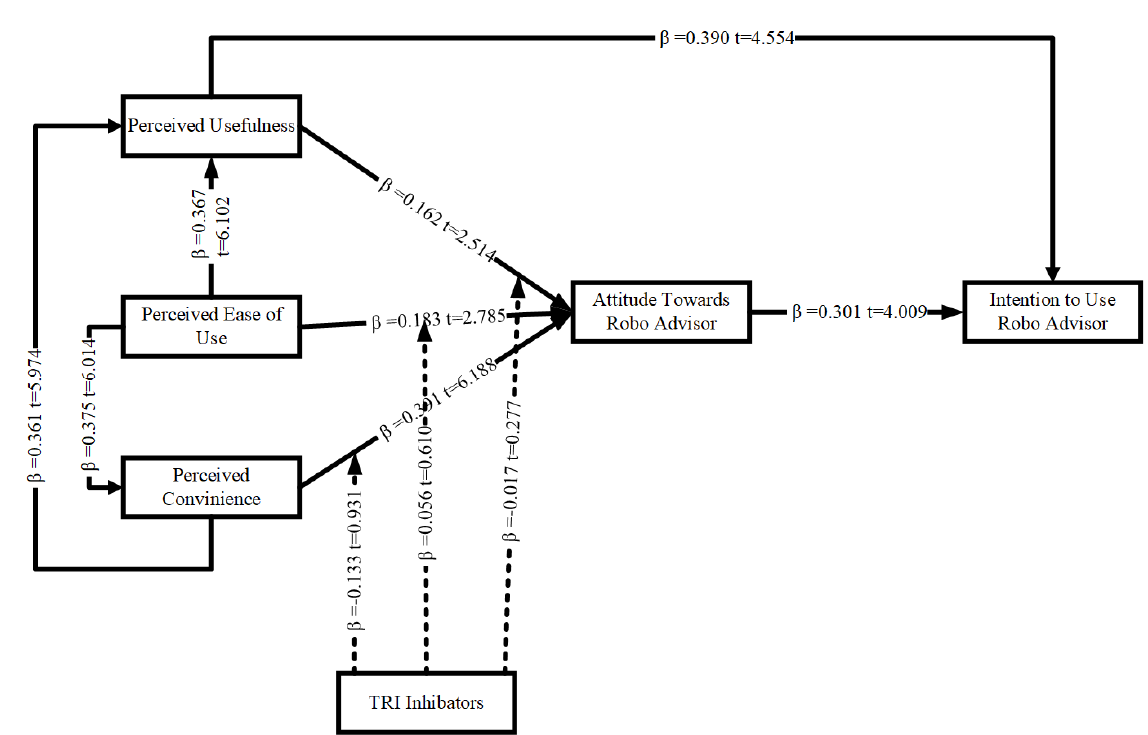
Figure A3. Moderating Effects of TRI Contributors.